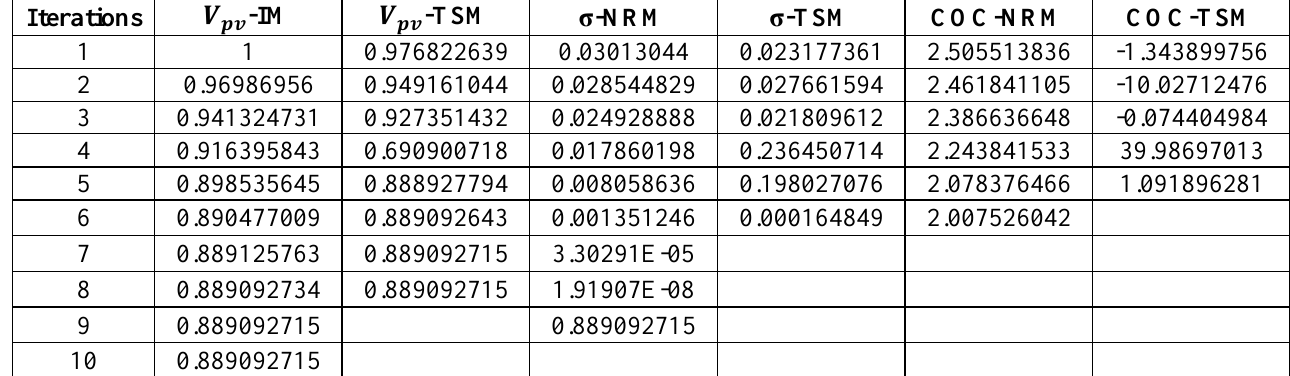
Table 5: The obtained values using NRM and TSM .